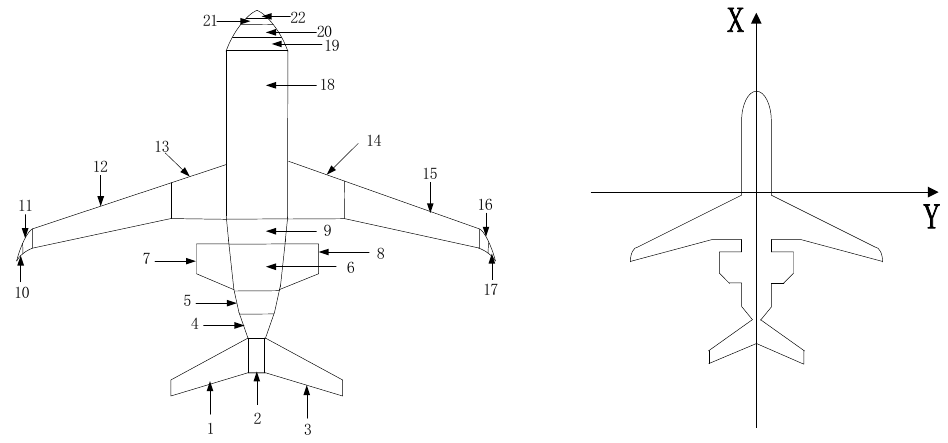
Figure 1. Induced velocities of different aircrafts at 174.95 kts. ( a ) Single vortex. ( b ) Twin vortex